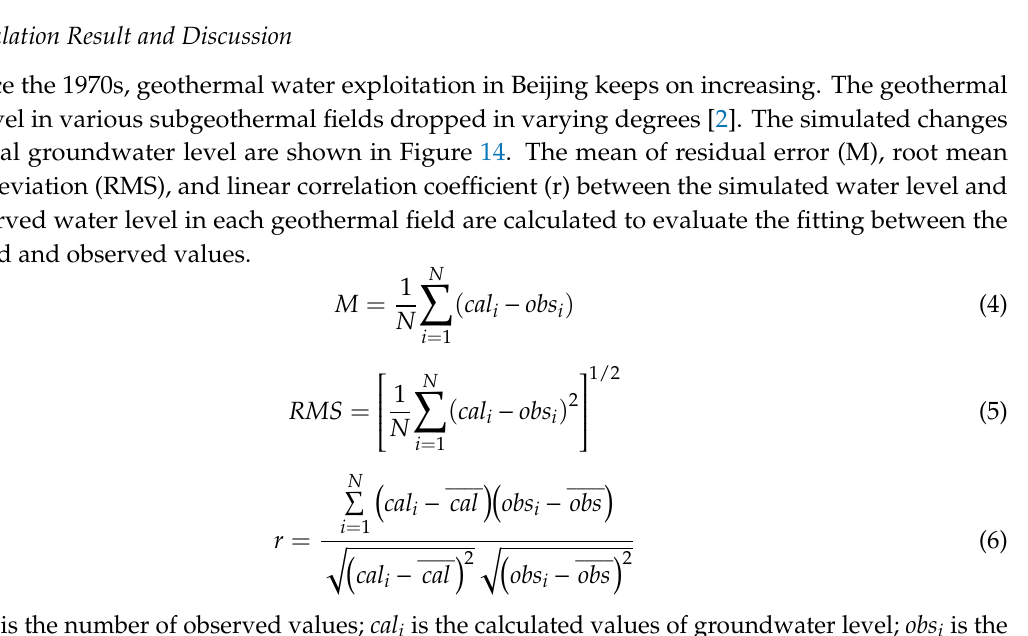
Figure 13. Parameter division of the simulation area. 1-32 represent the number of partition for parameter.